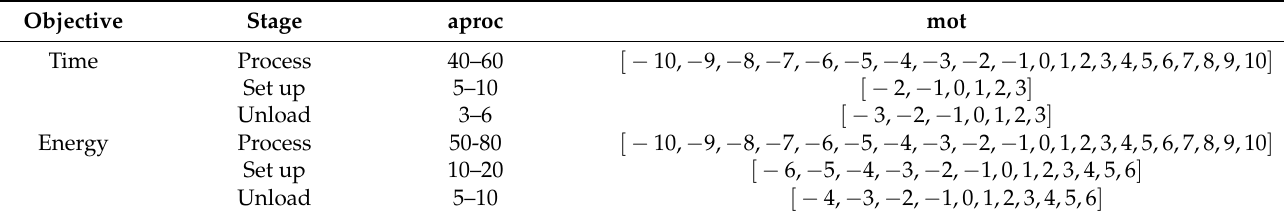
Table 3. The FJSP instances generation